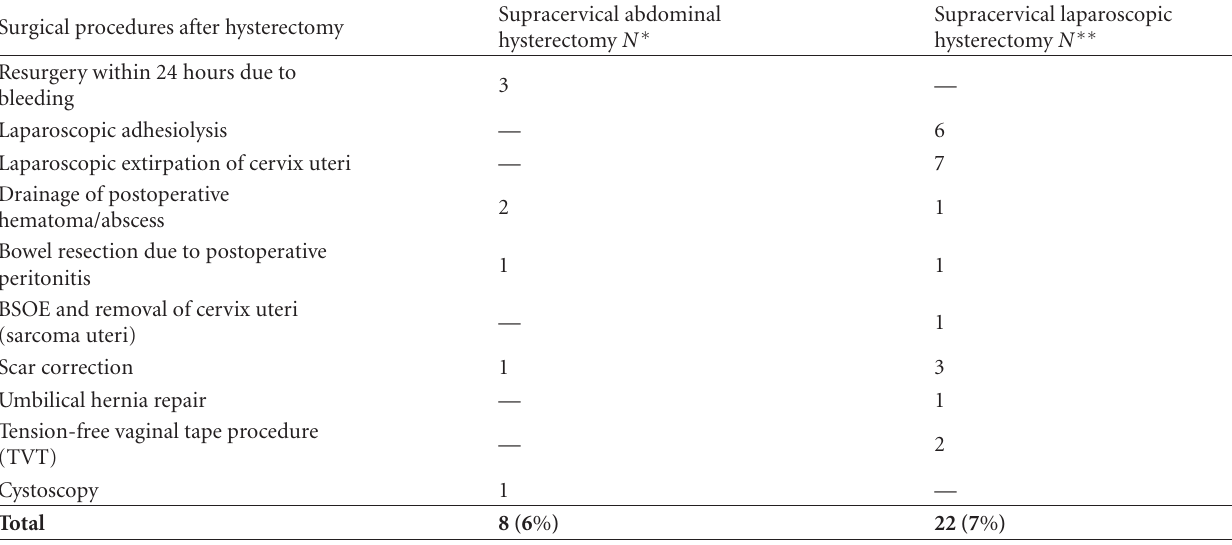
Table 3: Surgical procedures performed after the hysterectomy.